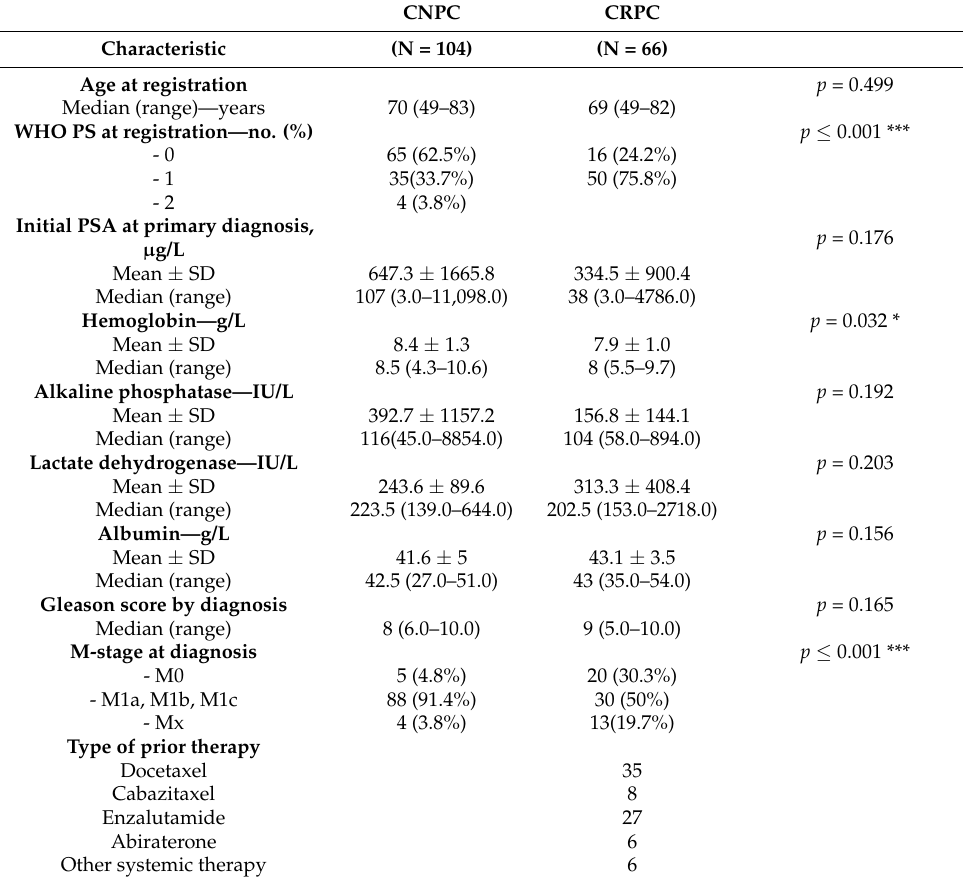
Table 2. Baseline